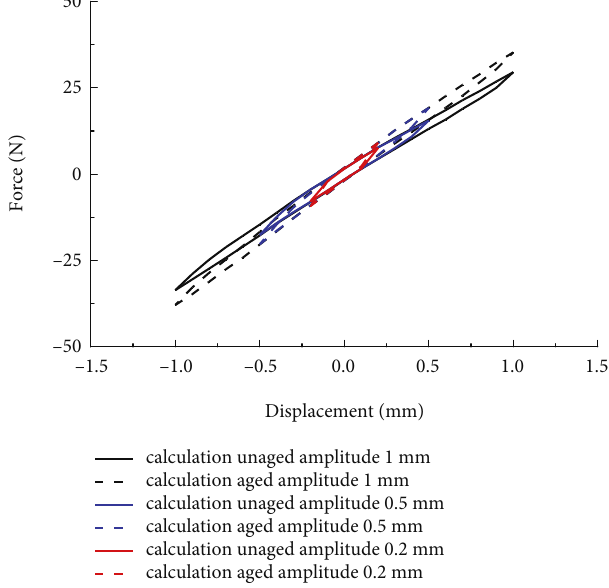
Figure 16: Hysteresis loops under the di ff erent